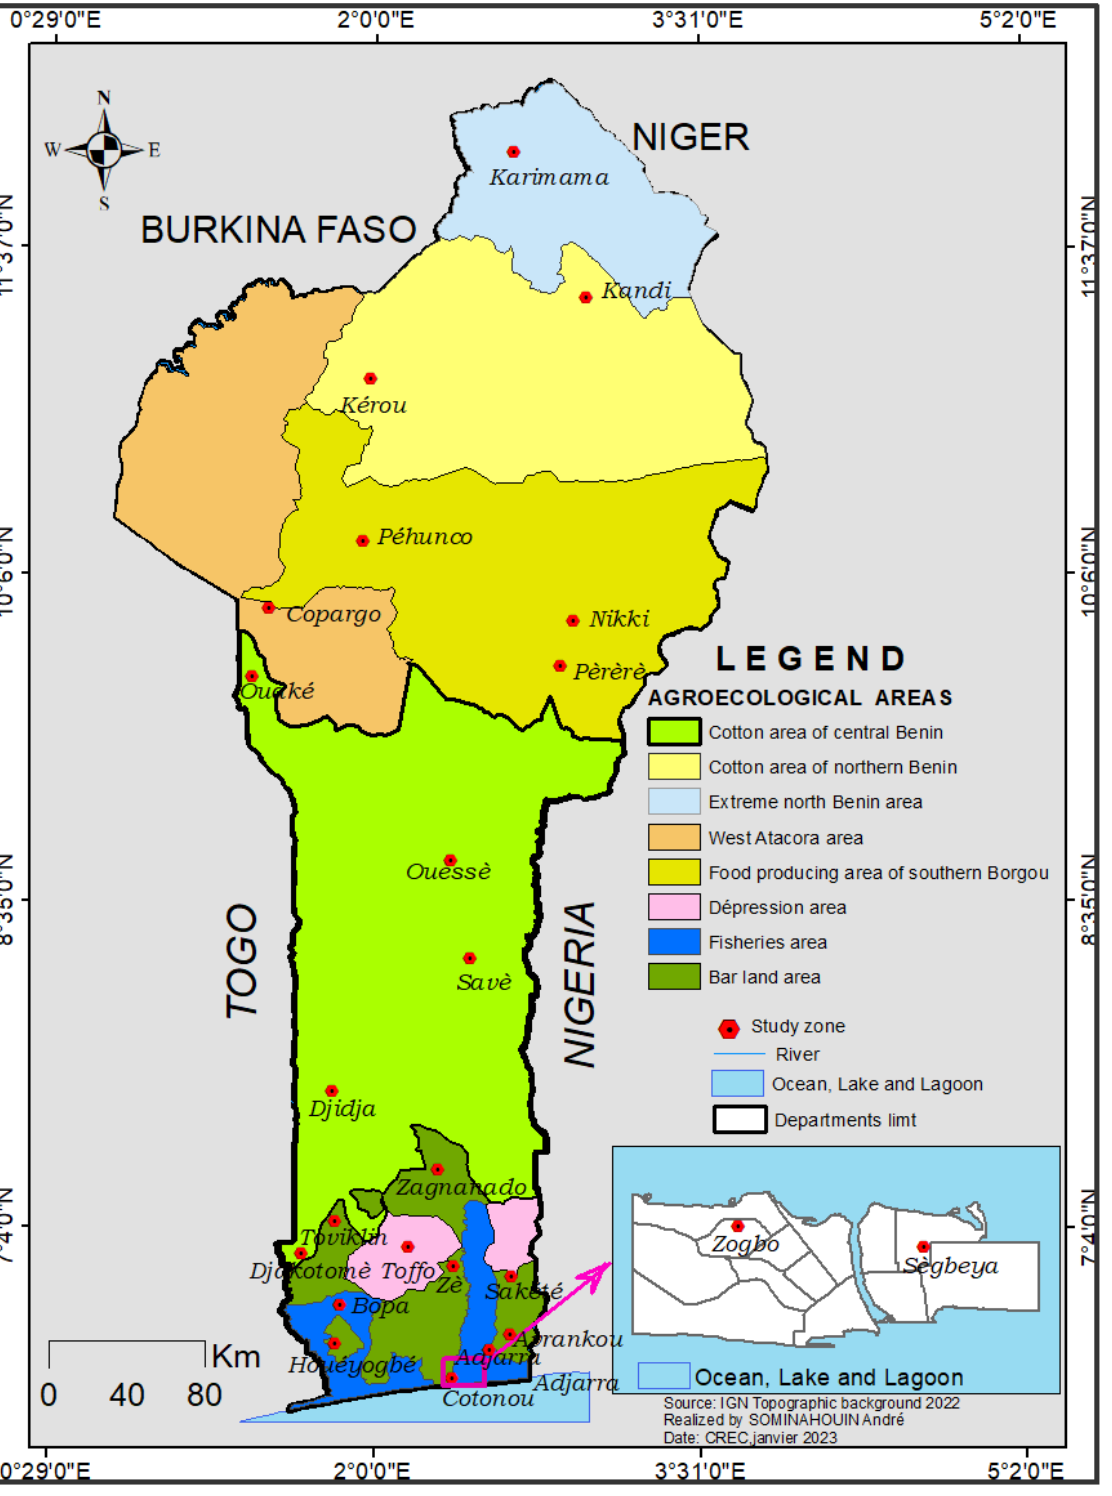
Figure 1. Map showing the study sites in the 12 departments presented according to the 8 eco-agricultural zones.